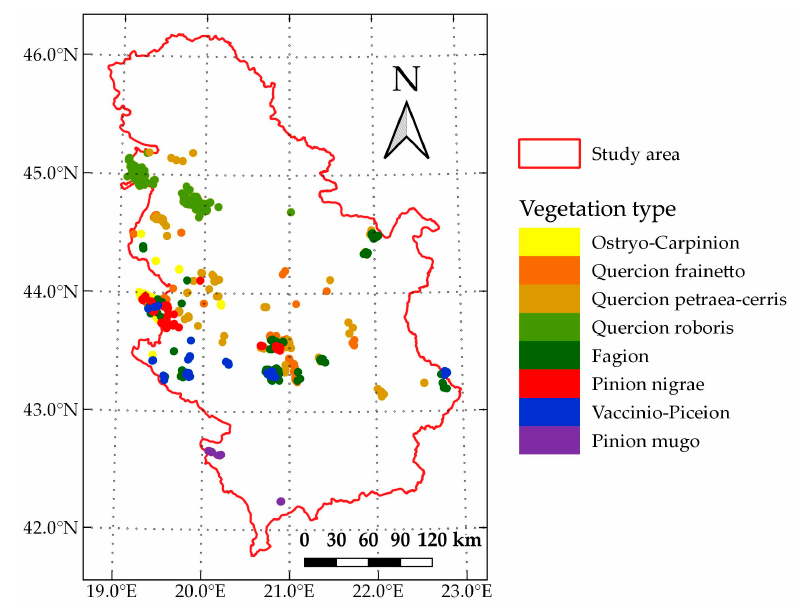
Figure 3. The overview of created woody vegetation polygons’ locations over the study area.